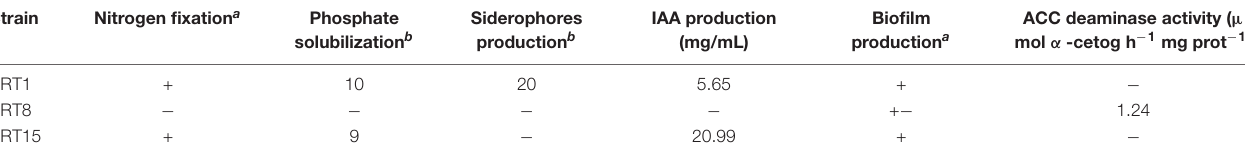
TABLE 2 | Plant growth promoting traits for bacterial consortia used in this study (Mesa-Marín et al., 2019c). Strain Nitrogen fixation